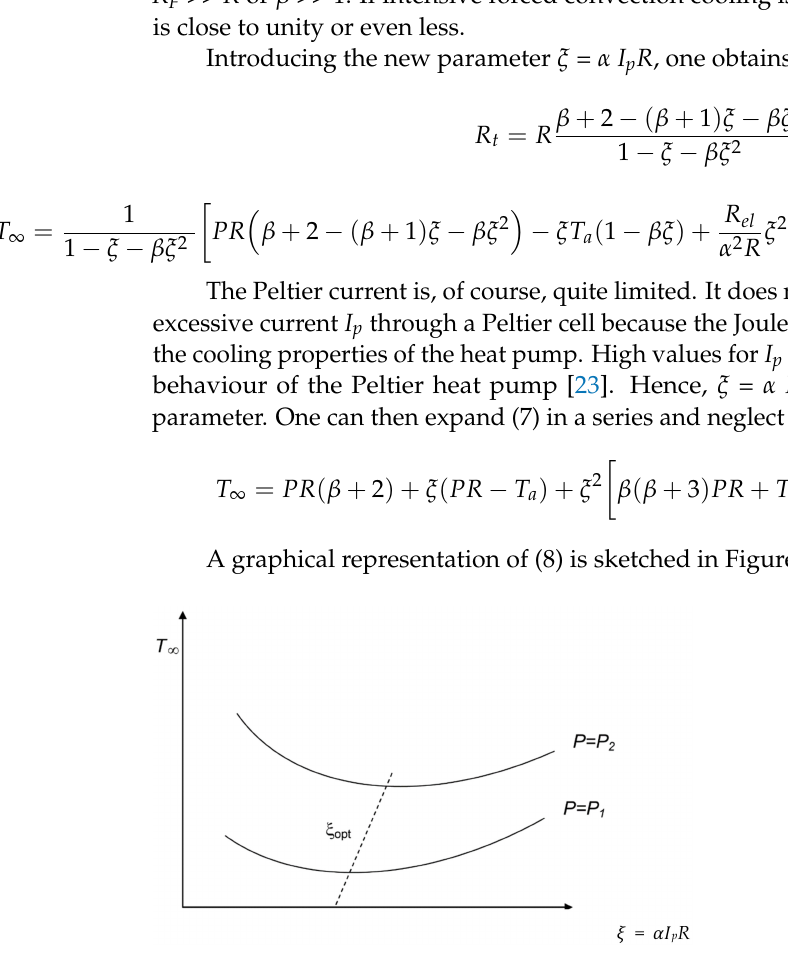
Figure 7. Temperature versus the parameter ξ